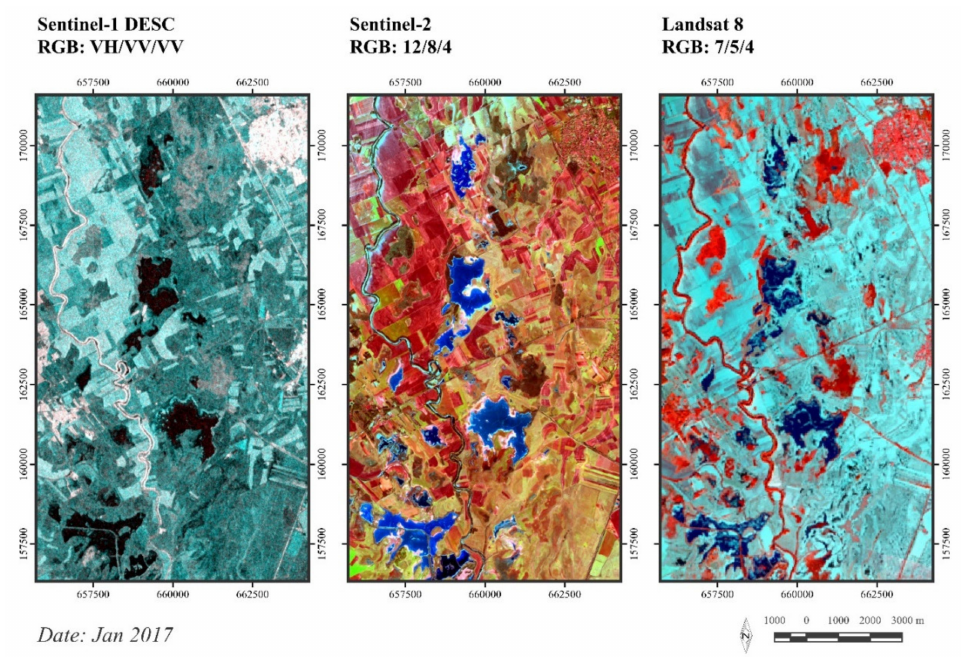
Figure 10. Comparison of Sentinel-1 radar, Sentinel-2, and Landsat 8 surface reflectance composites for January 2017—RGB: 7 / 4 / 3 and RGB: 12 / 8 / 4 both denote the combination of SWIR / NIR / visible red satellite image bands; SWIR: short-wave infrared band at λ = 2.1 µ m; NIR: near-infrared band at λ = 0.8–0.9 µ